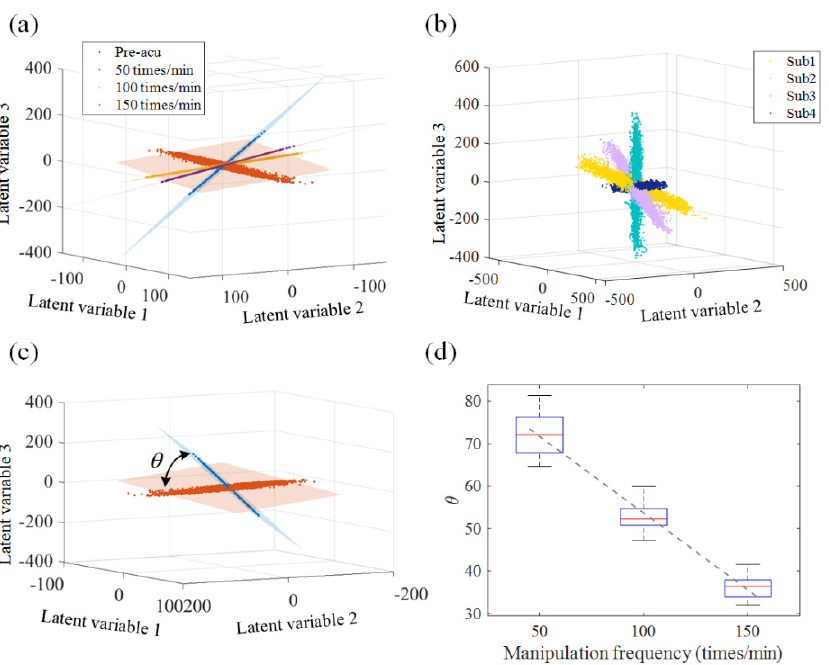
Figure 6. Latent variables in a 3-dimensional plane. ( a ) Different states of one subject. ( b ) Four ran-dom selected subjects in the pre-acupuncture period. Each color trace corresponds to a single trial. ( c ) Illustration of the variance of the latent dynamic space, where the angle between reference plane (pre-acupuncture state, orange) and acupuncture state (50 times/min, blue) was measured as θ . ( d ) Relationship between acupuncture manipulation and the plane included angle. Using VAE, the low-dimensional subspace of brain activity can be identified. The characteristics of the subspaces were determined by individuals and acupuncture stimulations.